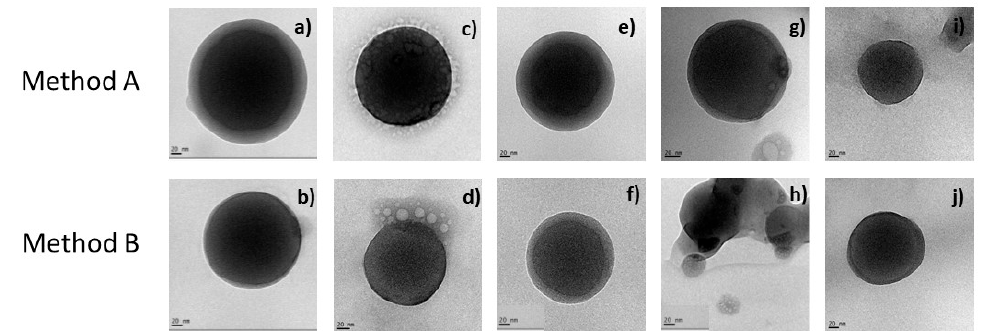
Figure 3. TEM images. Blank zein nanoparticles ( a ) 228 nm and ( b ) 179 nm. LAM/zein nanoparticles ( c ) 141 nm and ( d ) 129 nm. C 3 (LA) 2 /zein nanoparticles ( e ) 194 nm and ( f ) 136 nm. C 6 (LA) 2 /zein nanoparticles ( g ) 214 nm and ( h ) 164 nm. C 9 (LA) 2 /zein nanoparticles ( i ) 132 nm and ( j ) 121 nm. Magnification 40,000×.